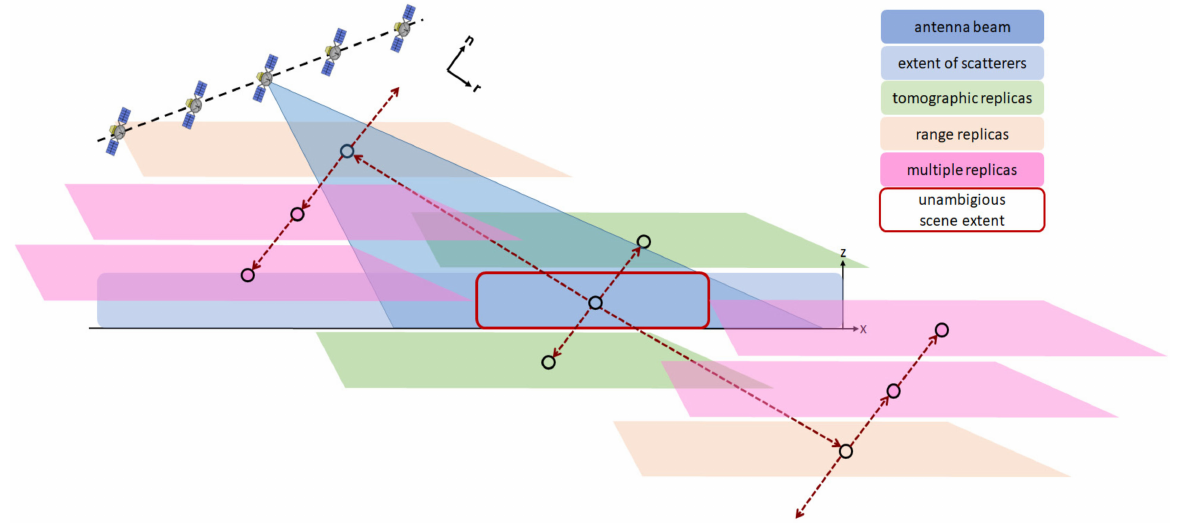
Figure 6. Range and tomographic replicas (ambiguities) and unambiguous scene